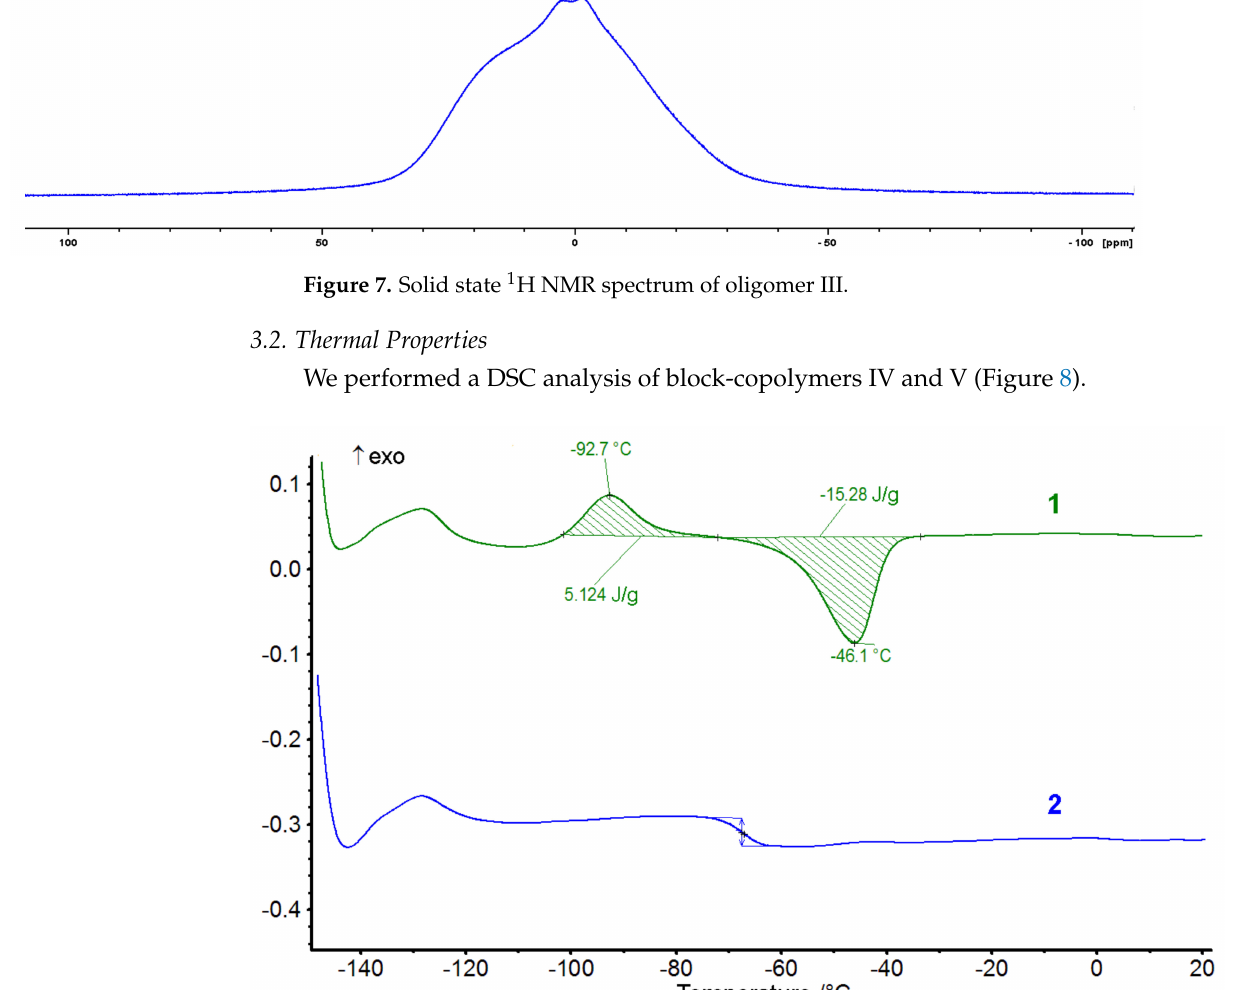
Figure 6. 13 C CP/MAS spectra of polymers III-V.